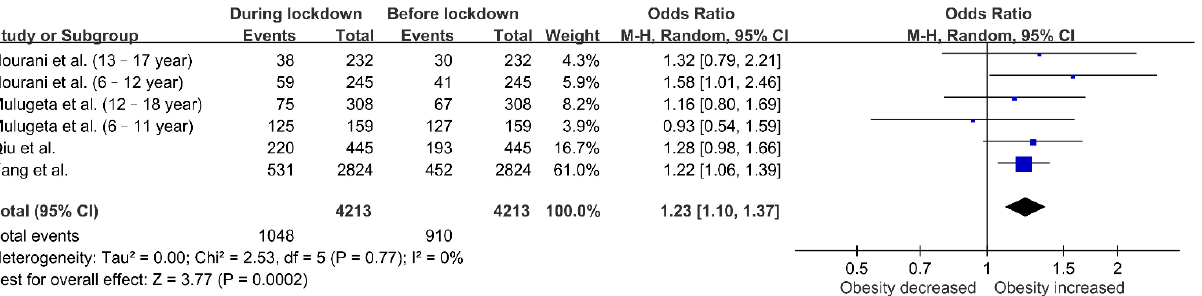
Nutrients 2021 , 13 , x FOR PEER REVIEW Figure 4. Associations between lockdown and obesity in children. The obesity rate increased during lockdown.